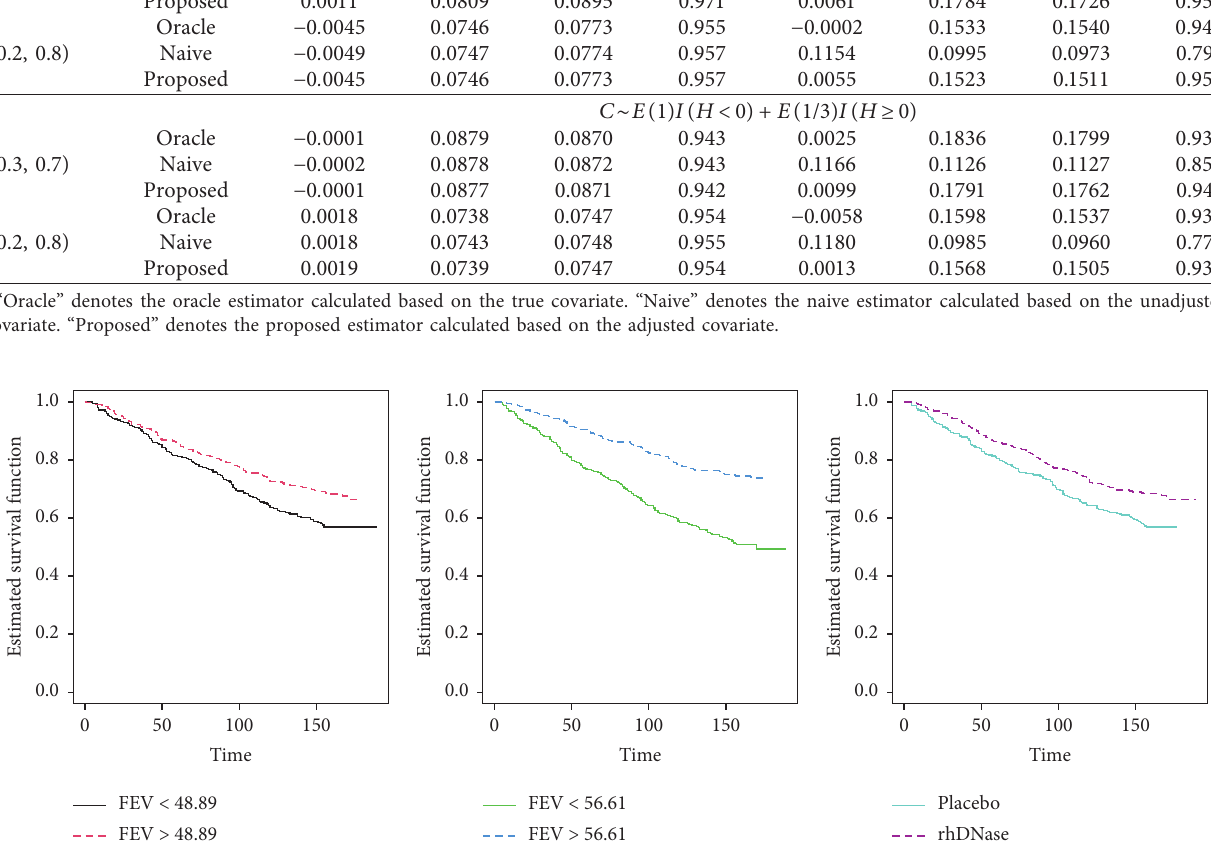
Table 4: Simulation results when λ